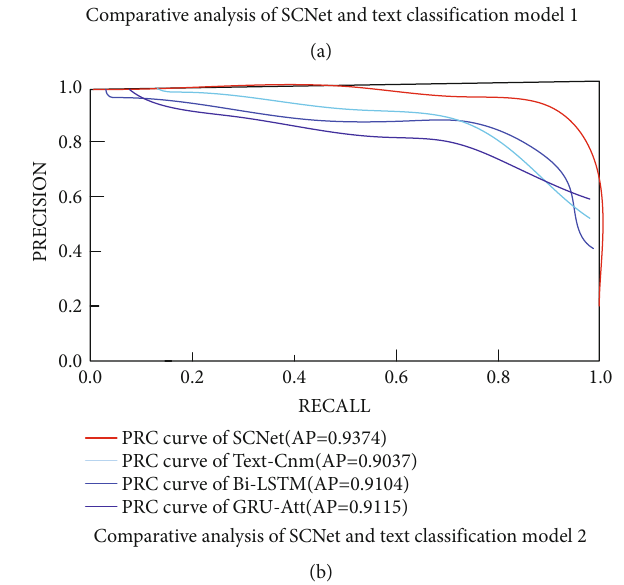
Figure 9: Comparative analysis of SCNet and text classi fi cation